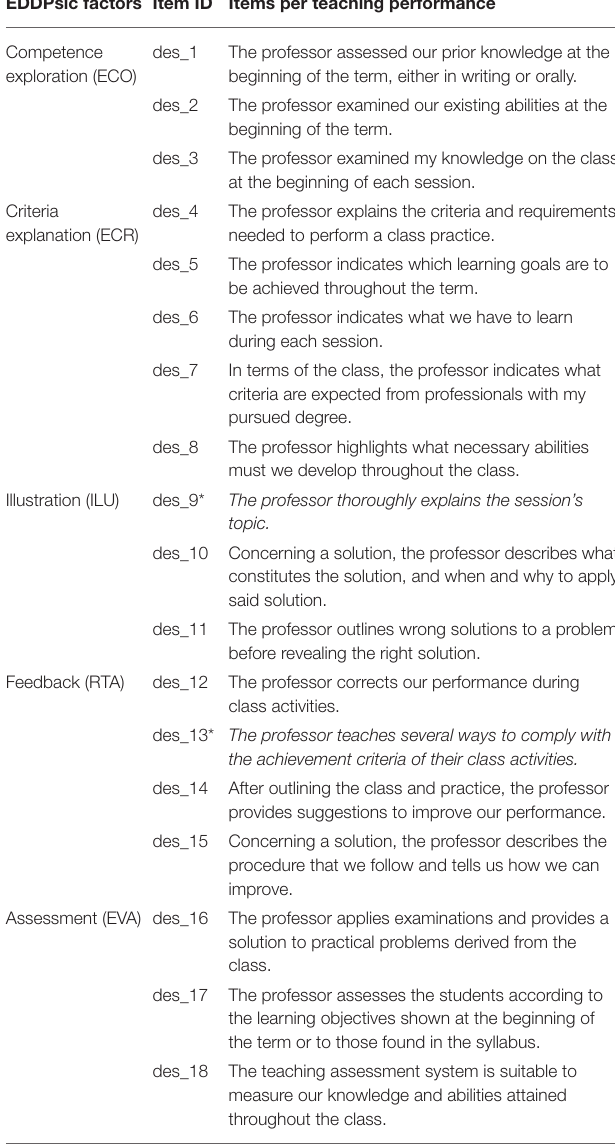
TABLE 1 | Sample of study participants per sex and course term. Variable